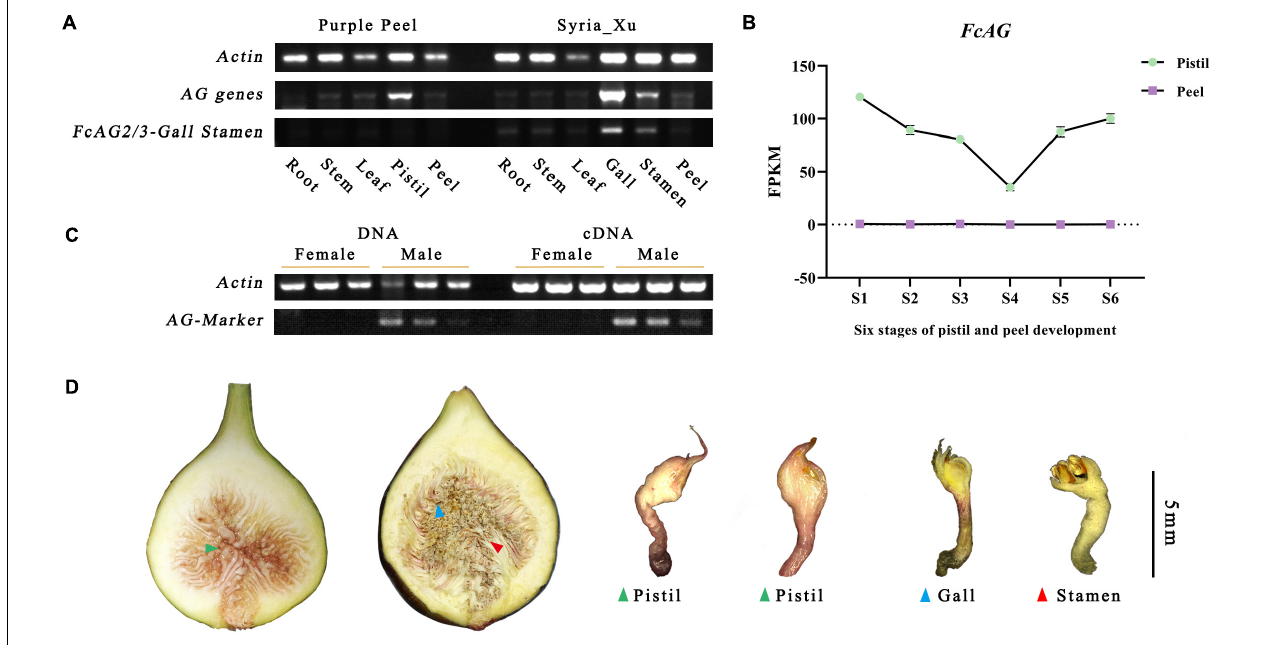
FIGURE 3 | Specific expression of AG genes revealed by semi-quantitative RT-PCR and fig fruit transcriptome. (A) AG genes are widely expressed in fig flowers, but male-specific AG genes FcAG2/3-Gall_Stamen are only found in fig galls and stamens. (B) Transcriptome data of “Purple Peel” fruit reveal that the FcAG gene is only expressed in the pistils; no expression was detected in the peel. (C) AG-Marker PCR products are only identified in male individuals; both DNA and cDNA can be used as the template. (D) Sectional view of a female fig fruit (left) and male fig fruit (right). Both were confirmed by our sex-identification